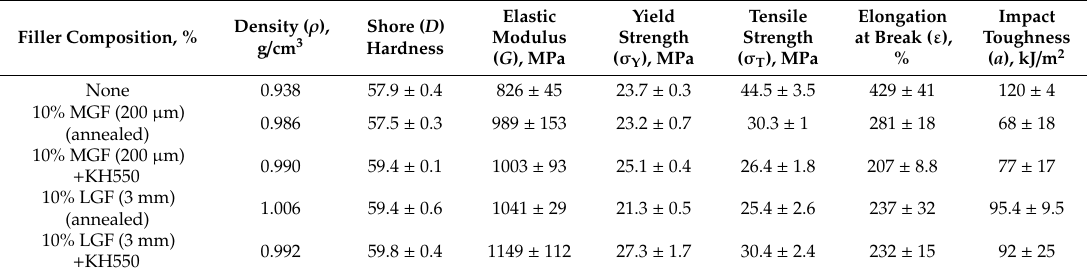
Table 5. Mechanical properties of GUR 4022-6 and GUR 4022-6-based